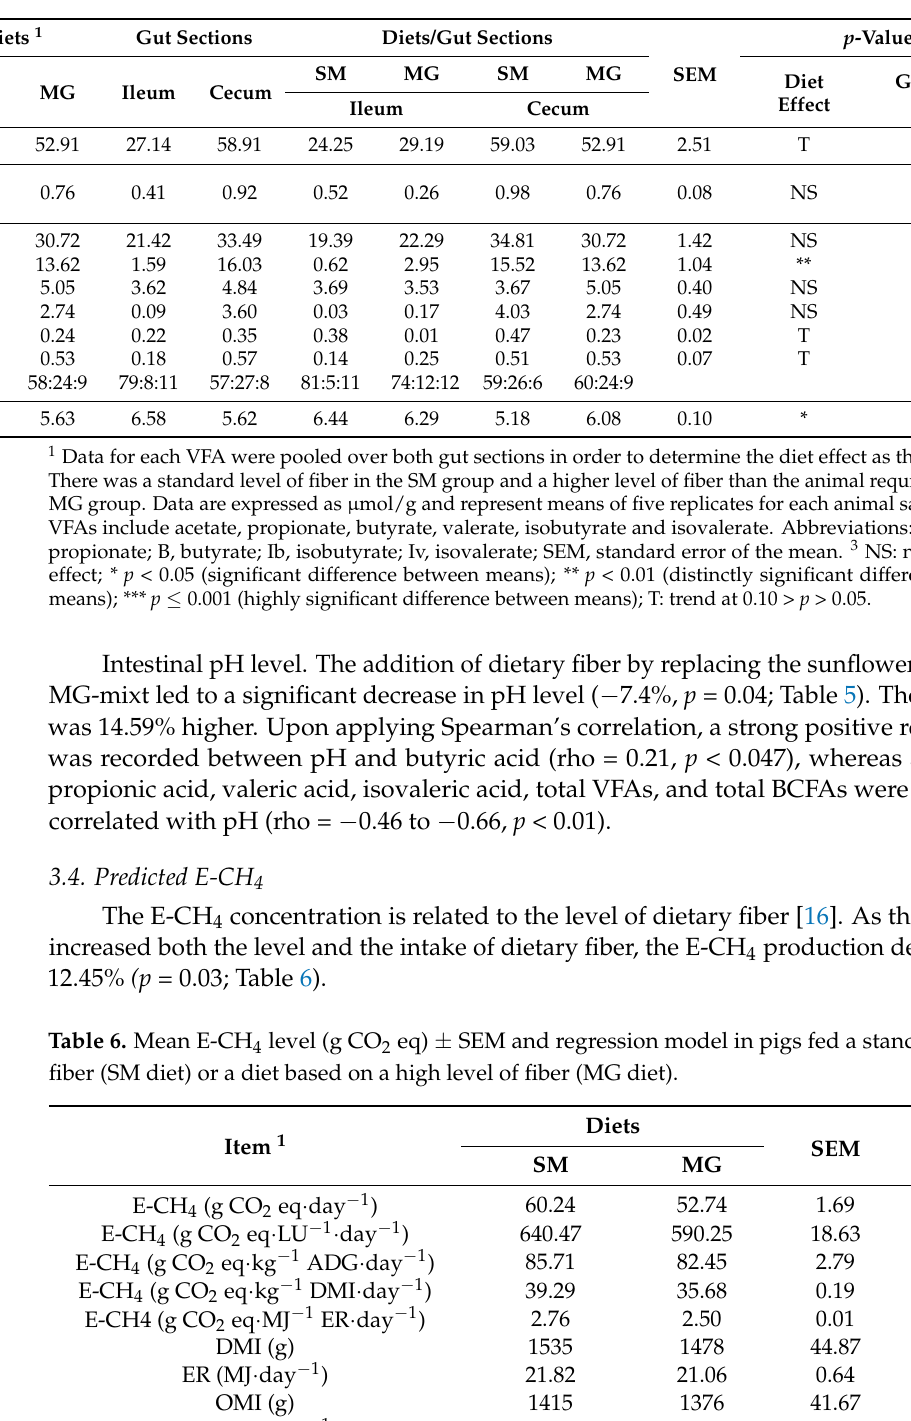
Table 5. Concentration ( µ mol/g) and molar ratio of VFAs ± SEM in distal ileum and cecum gut sections from Topigs hybrid pigs (44 ± 3.30 kg) fed a standard level of fiber (SM diet) or a diet based on a high level of fiber (MG diet).